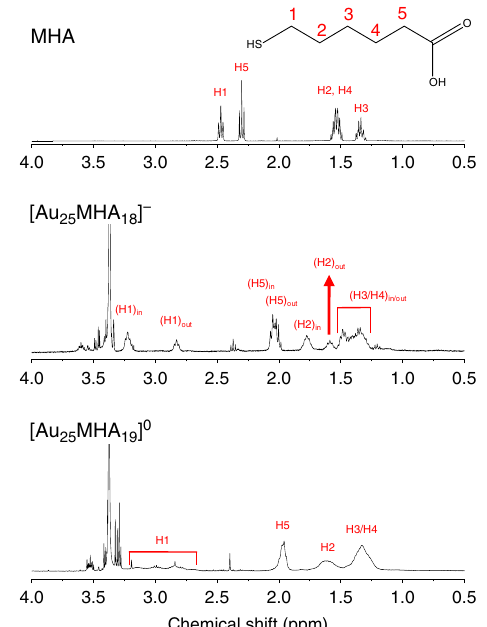
Fig. 6 1 H-NMR testing of the ligand shell. 1 H-NMR spectra of MHA ligand, [Au 25 MHA 18 ] − , and [Au 25 MHA 19 ] 0 . Sharp peaks around chemical shift of 3.30 and 2.40 ppm are from impurities introduced in PAGE and ultra fi ltration process which are hard to be removed and